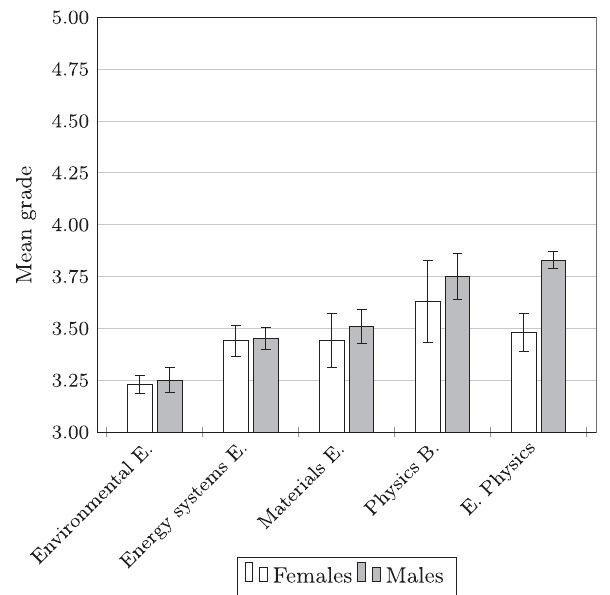
FIG. 1. Mean grades for female, male and all students on the five major programs on the course. Error bars indicate standard error of the